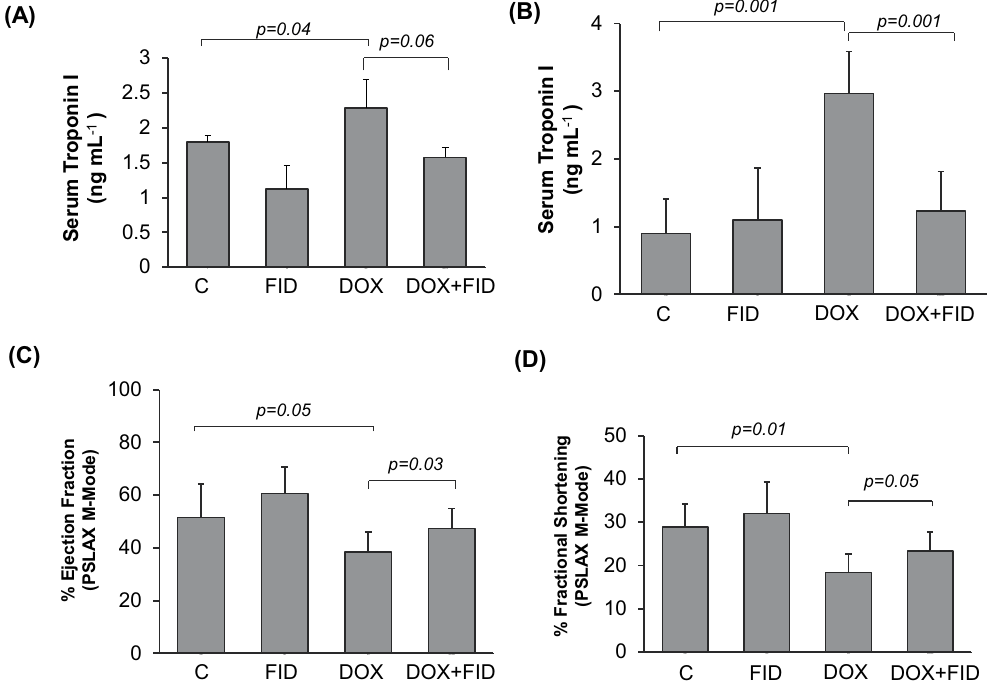
Figure 6. Fidarestat ameliorates DOX-induced cardiac dysfunction in vivo . Serum troponin I level in ( A ) tumor-bearing nude mice after 21 days of treatment with DOX (4 mg kg − 1 wk − 1 i.p) alone or with fidarestat ( B